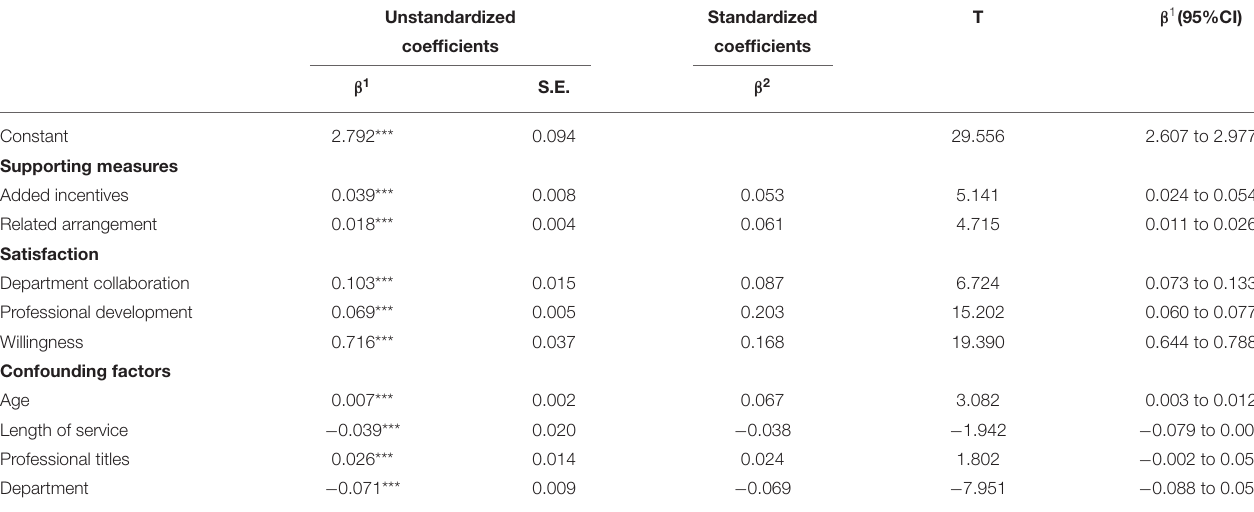
TABLE 4 | Multiple linear regression